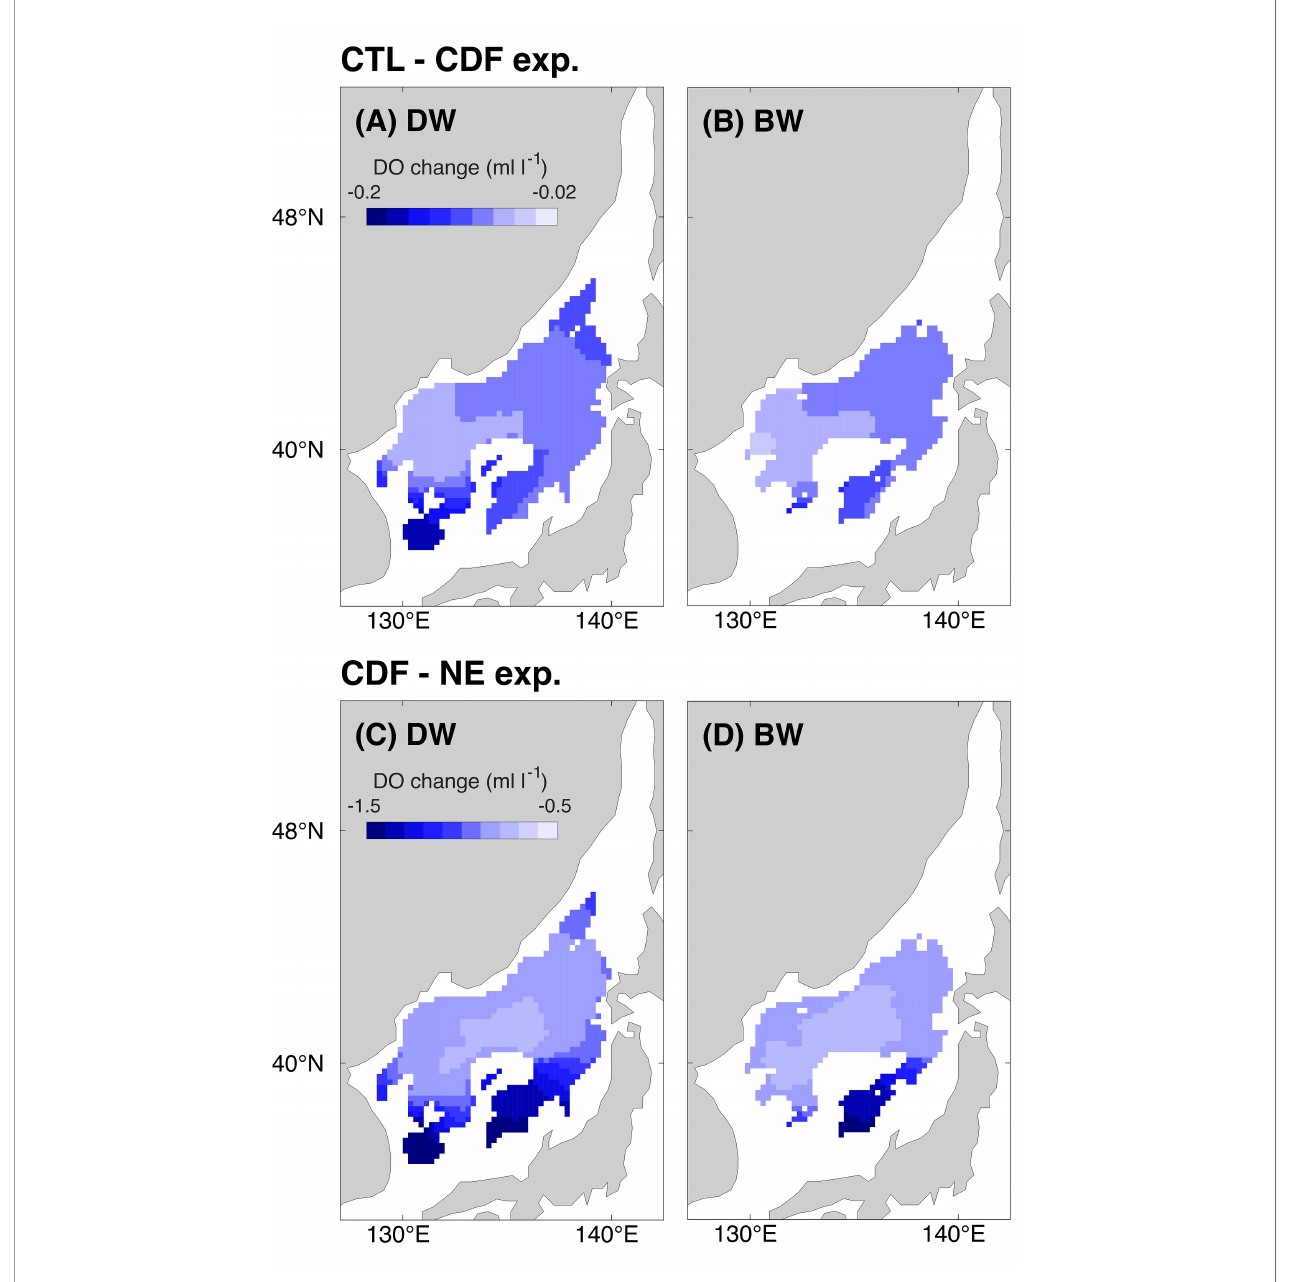
FIGURE 10 | Spatial distribution of the changes in the dissolved oxygen (DO) difference (A, B) between the control (CTL) and the constant detritus fl ux (CDF) experiments; and (C, D) between the CDF and the no-ecosystem (NE) experiments for the 36-year period (1980 to 2015) in the depth range from 1618 to 2250 m (deep water: DW) and 2250 m to the bottom (bottom water: